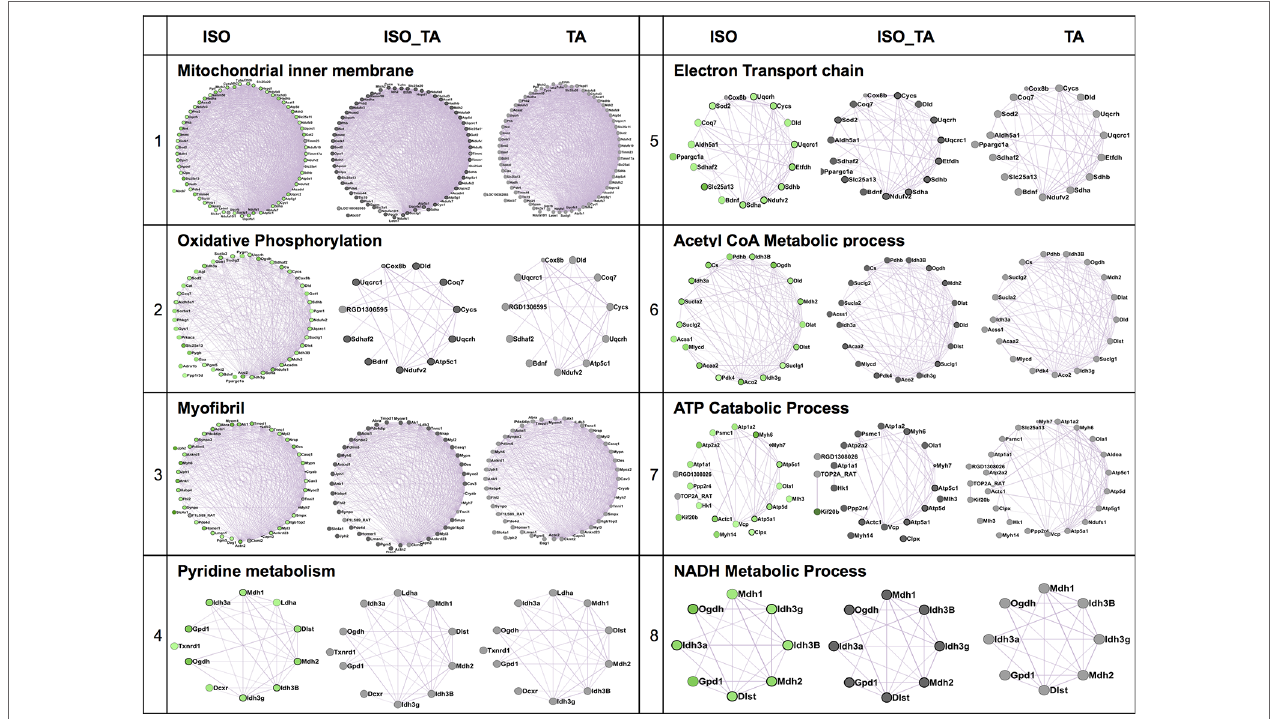
FIgURE 4 | Comparison of enriched non-redundant biological processes represented as “ degree sorted circular view ” networks of downregulated genes in ISO group extracted from "GeneMANIA" (Cytoscape plugins) along with ISO_TA and TA group overlaid network. Upregulated, downregulated, and undifferentiated gene represented as red node, green node, and gray node